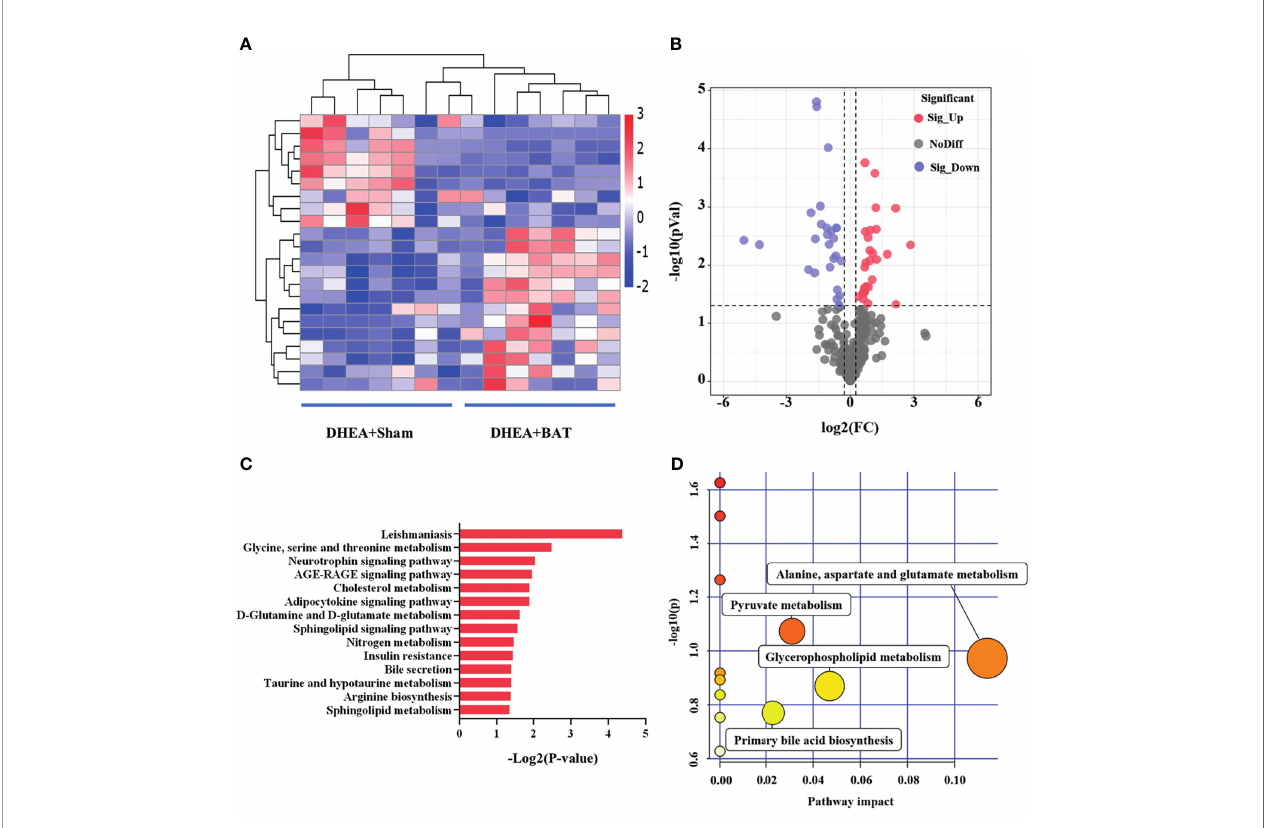
FIGURE 5 | Differential analysis of the metabolites in brown adipose tissue (BAT) from the DHEA+Sham and DHEA+BAT groups. (A) Heatmap of the 22 metabolites that were differentially expressed between the DHEA+Sham ( n = 7) and DHEA+BAT ( n = 7) groups. Blue to red equates to an increase in metabolite expression. (B) Volcano plot of all metabolites expressed in the DHEA+Sham and DHEA+BAT groups. (C) KEGG pathway analysis of the differentially expressed metabolites. (D) All matched pathways are displayed as circles analyzed with MetaboAnalyst 3.0. Potential target pathways were selected either by impact values from pathway topology analysis or by negative log p -values from pathway enrichment analysis. The size of the bubble represents the number of metabolites enriched. KEGG , Kyoto Encyclopedia of Genes and Genomes.